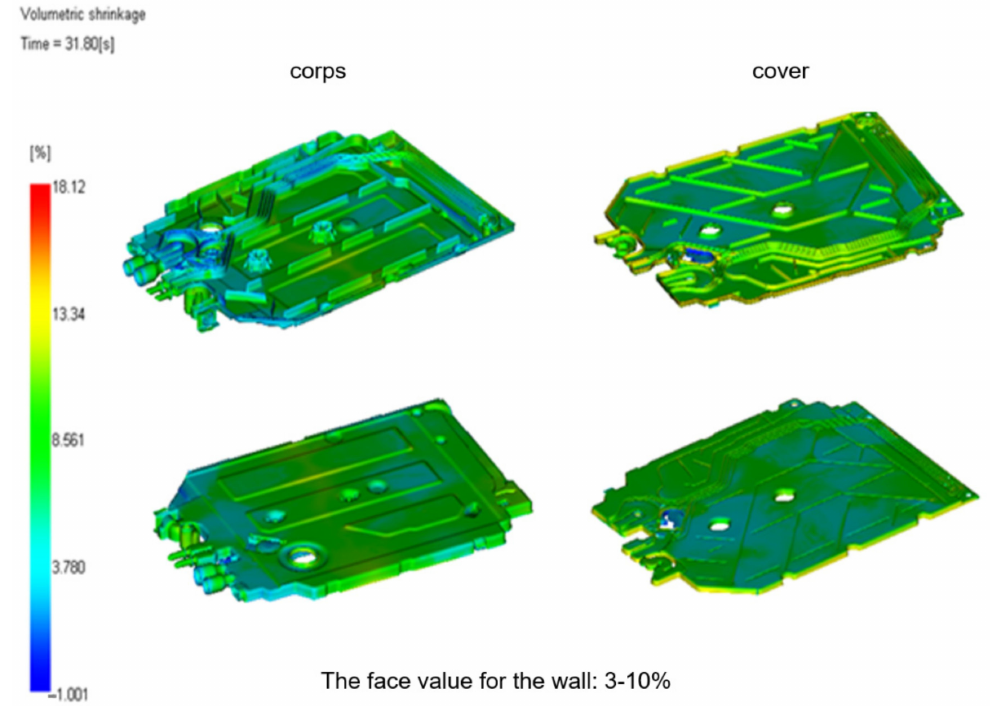
Figure 20. Volume shrinkage of tested moldings of the flow